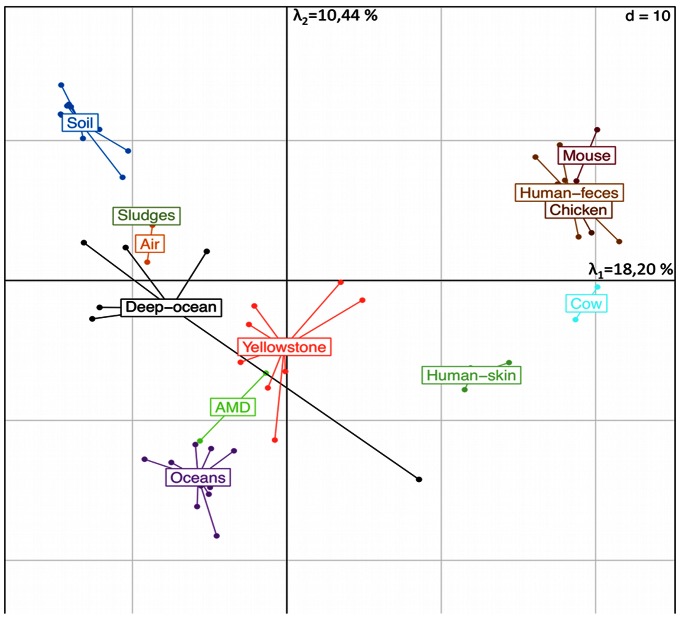
Inter-environmental comparison with a principal component analysis.Comparison of the four skin datasets generated with 65 other publicly available environmental metagenomic datasets by PCA using the relative distribution of annotated reads in each dataset. In this case, data were obtained using the same cut-off (e-value cut-off <10−5) and SEED functional level 3 subsystem (deeper characterization, ≈ 800 functions are compared in each dataset).